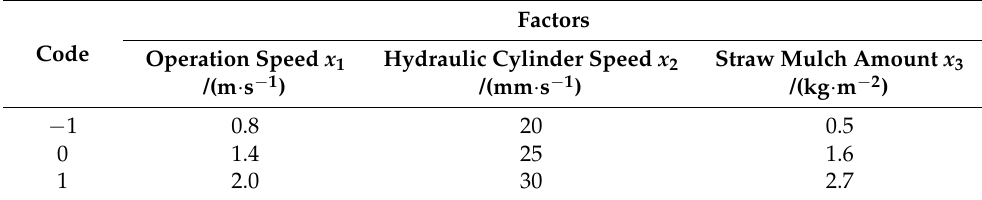
Table 1. Code of factor